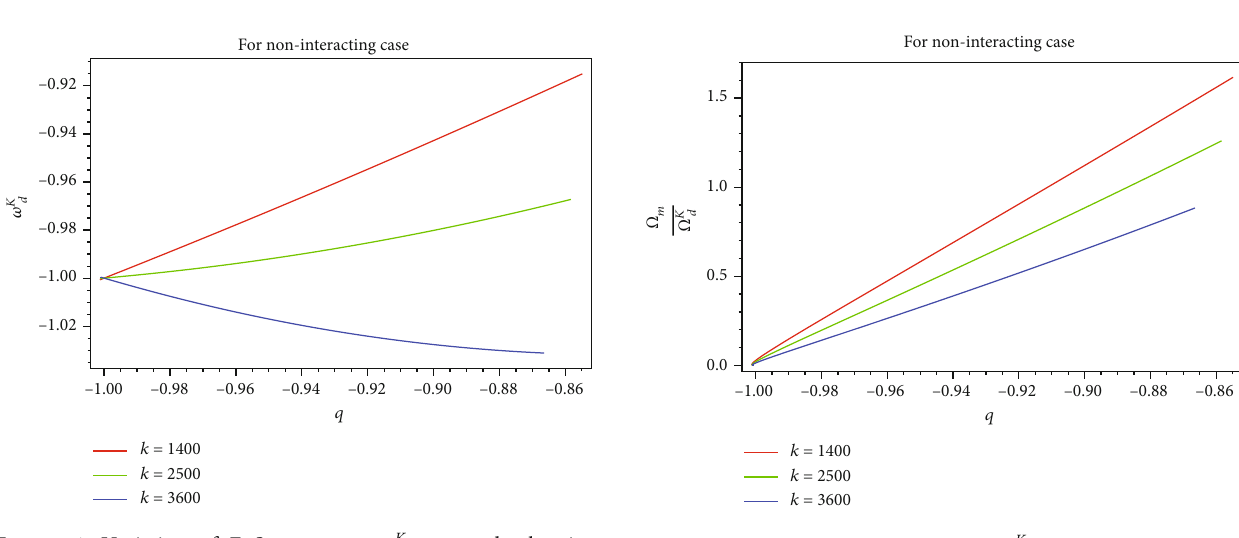
Figure 6: Plot of ~ r = Ω